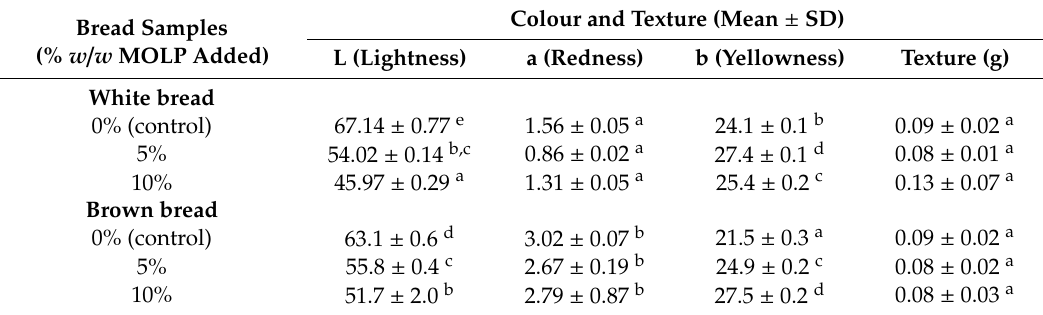
Table 2. The effect of Moringa oleifera leaf powder fortification on colour and texture of white and brown breads.